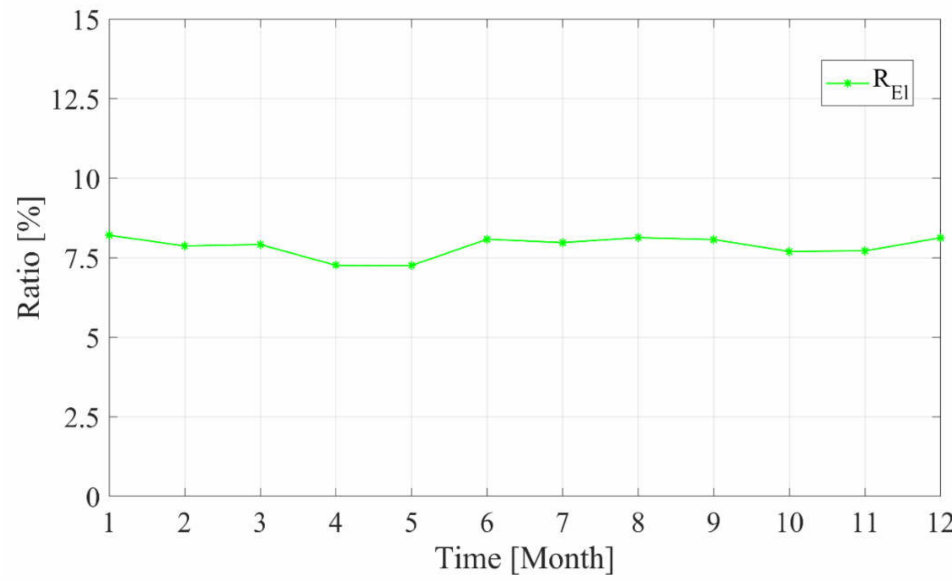
Figure 11. Monthly electric energy differences.